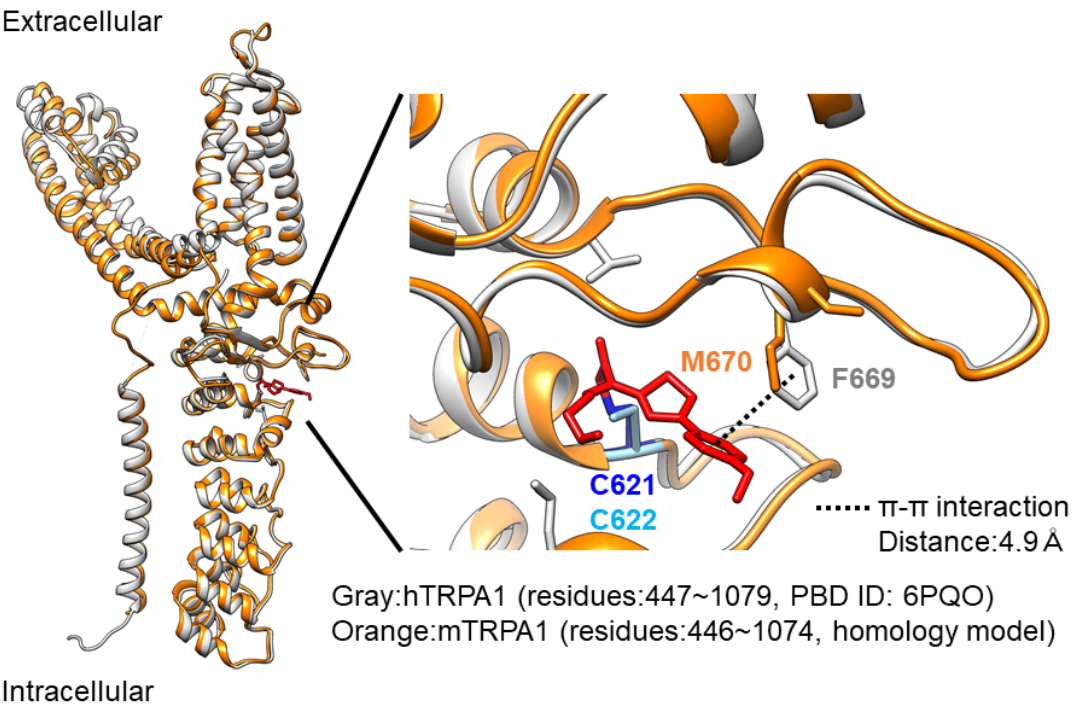
Figure 7. Structure modeling of the interaction of JT010 with F669 on hTRPA1 (PDB ID: 6PQO) and M670 on mTRPA1. Ribbon diagrams colored grey of the hTRPA1 atomic model for residues 447–1079 are shown on the left. The Modeller optimized model of mTRPA1 for residues 446–1074 and JT010 are colored orange and red, respectively. A close-up view of the JT010 binding sites is shown on the right. The methoxyphenyl group of JT010 potentially interacts with the phenyl of F669 in hTRPA1 in a π - π interaction manner. The coordination is shown by the dotted line with a 4.9 Å distance. Out of 100 models, the structure with the lowest zDOPE score (2.69) was adopted (see also Materials and Methods).